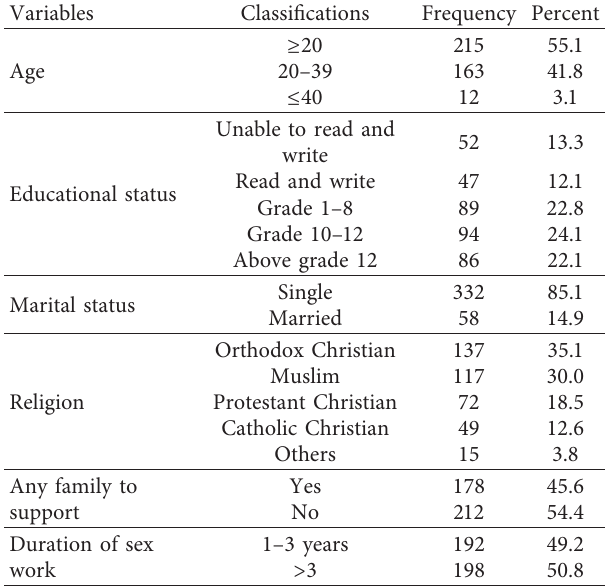
Table 1: Sociodemographic characteristics of FSWs working in licensed drinking establishments in Adama Town, Oromia regional state, Ethiopia, March 2017 ( N �